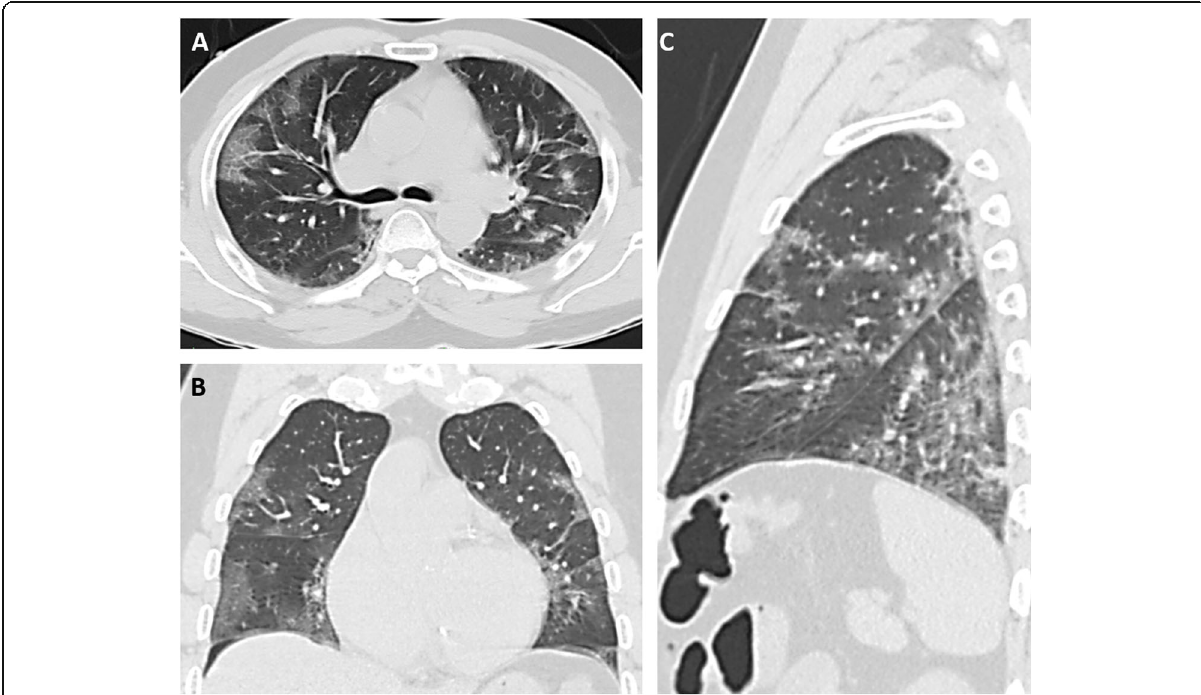
Fig. 1 Non-contrast CT of a 42-year-old male with fever, sore throat, and shortness of breath, rt RT-PCR +VE, ( A - C ): A , axial; B , coronal; and C , sagittal non-contrast CT scan lung window show bilateral multifocal peripheral and pleural-based ground glass opacity with linear opacities and interlobular thickening